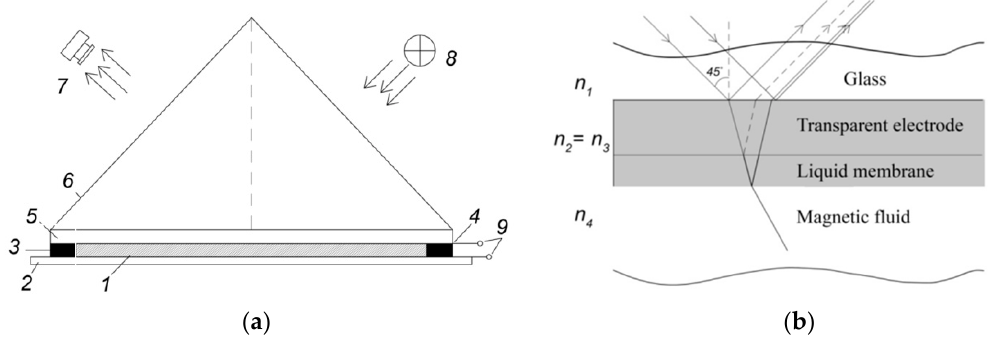
Figure 1. ( a ) Schematic of an experimental device: 1—ferrocolloid; 2 and 5—ITO-covered glass; 3 and 4—polystyrene insulating gaskets; 6—rectangular isosceles prism; 7—camera; 8—light source; 9—electrodes. ( b ) Multilayer structure: glass–transparent electrode-liquid membrane-ferrocolloid. The light path is shown by arrows.